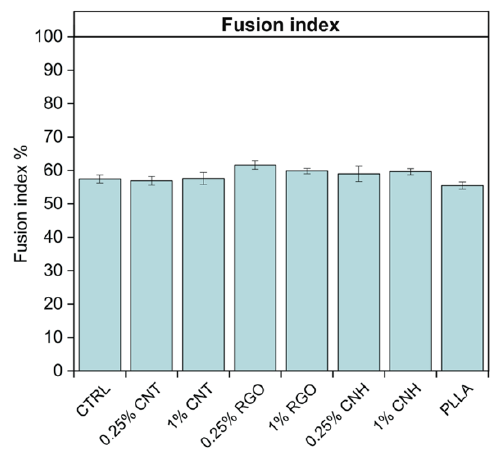
Figure 5. Effect of the different scaffolds on myoblasts fusion during differentiation towards Figure 5. E ff ect of the di ff erent sca ff olds on myoblasts fusion during di ff erentiation towards myotubes. myotubes. CTRL: differentiative medium w/o scaffold; 0.25% – 1%CNT: 0.25% – 1% wt CNT@PLLA; CTRL: di ff erentiative medium w / o sca ff old; 0.25–1%CNT: 0.25–1% wt CNT@PLLA; 0.25–1%RGO: 0.25–1% wt RGO@PLLA; 0.25–1%CNH: 0.25–1% wt CNH@PLLA; PLLA: bare PLLA. Data are shown 0.25% – 1%RGO: 0.25% – 1% wt RGO@PLLA; 0.25% – 1%CNH: 0.25% – 1% wt CNH@PLLA; PLLA: bare PLLA. Data are shown as mean ± SEM.